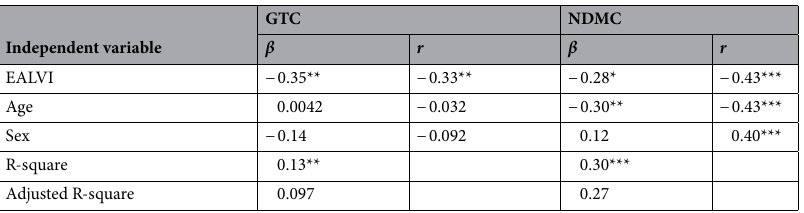
Table 4. Results of multiple regression analyses on HAM-D scores. ***( p < 1.0 × 10 −3 ), **( p < 1.0 × 10 −2 ), *( p < 5.0 × 10 −2 ). β denotes the standardized partial regression coefficient. r represents the correlation coefficient between HAM-D score and each independent